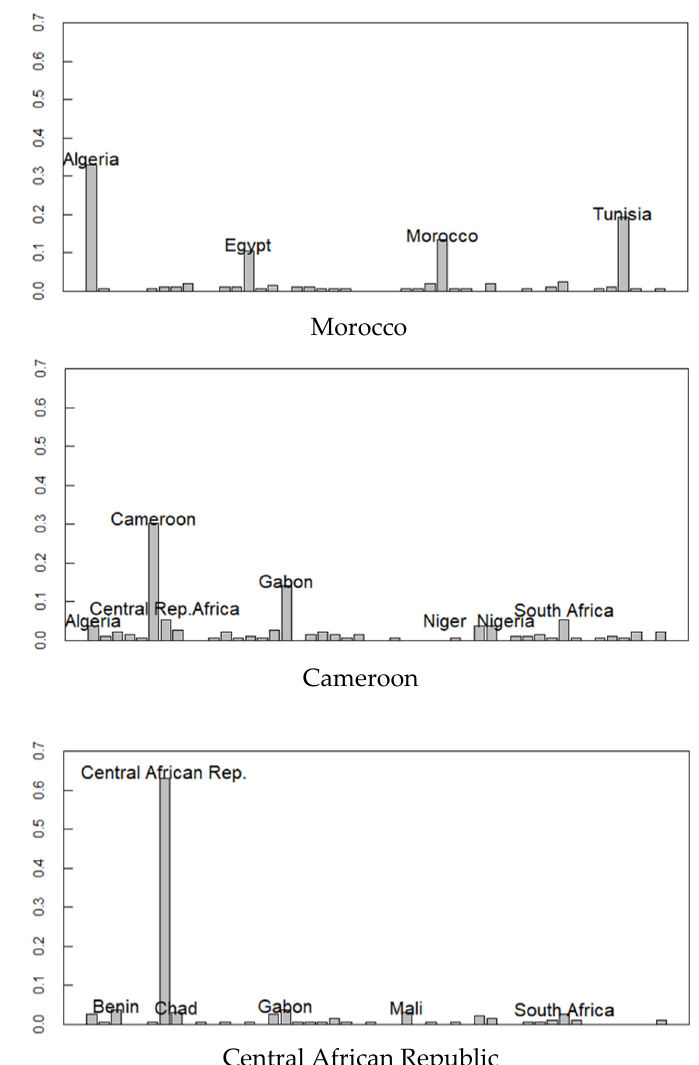
Figure 7. Example of ethnic distribution in Africa; (x-axis) countries; (y-axis) Figure 6. Example of ethnic distribution in Africa; (x-axis) countries; (y-axis) probability